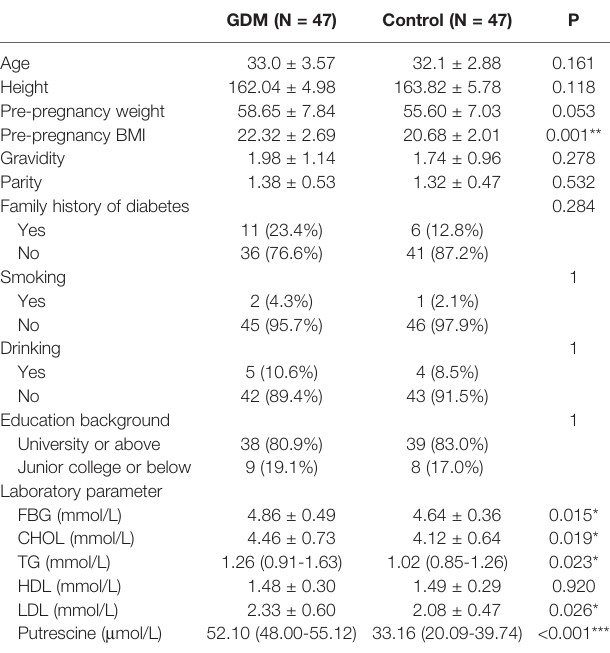
TABLE 1 | Anthropometric, clinical and laboratory variables in women with GDM and